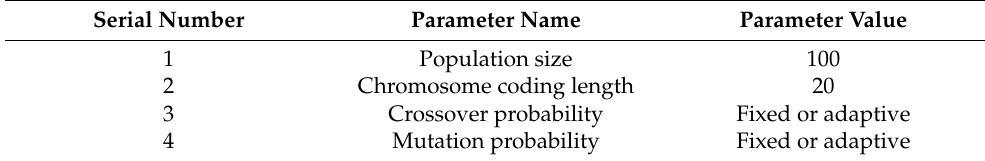
Table 2. Parameters of the genetic